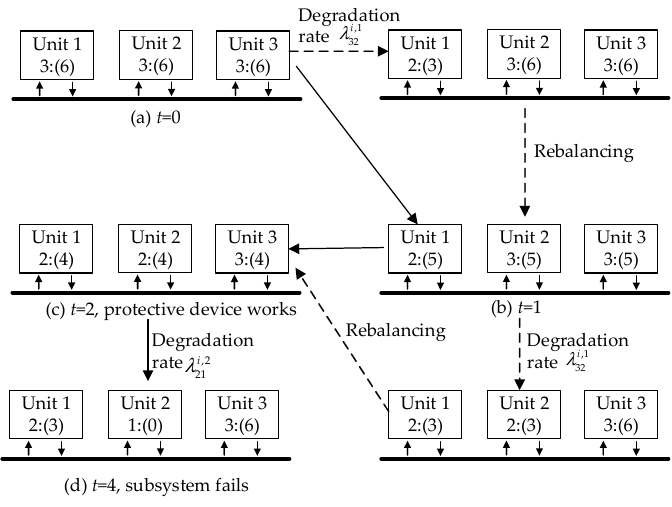
Figure 2. Possible operation cases of the subsystem i. 3. Figure 5 is not clear in the published PDF. It should be presented in the following.